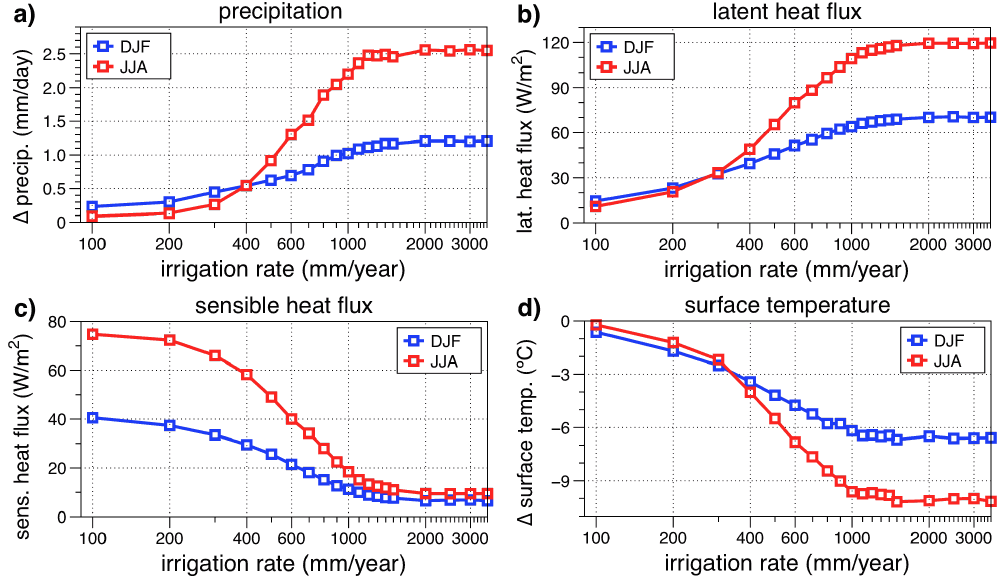
Fig. 2. Seasonal responses of the irrigation rate to common climatological variables: (a) precipitation, (b) latent heat flux, (c) sensible heat flux, and (d) surface temperature in response to the increased irrigation rate, averaged over the entire irrigated